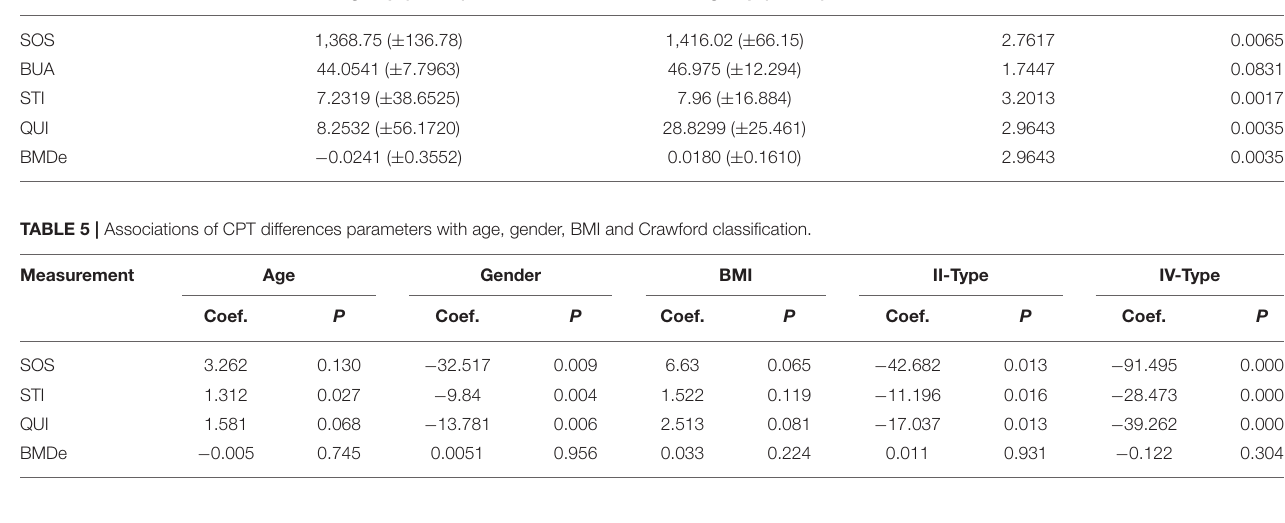
TABLE 4 | Intergroup differences in the measurements of quantitative ultrasound. Measurement CPT group ( n = 74) SOS